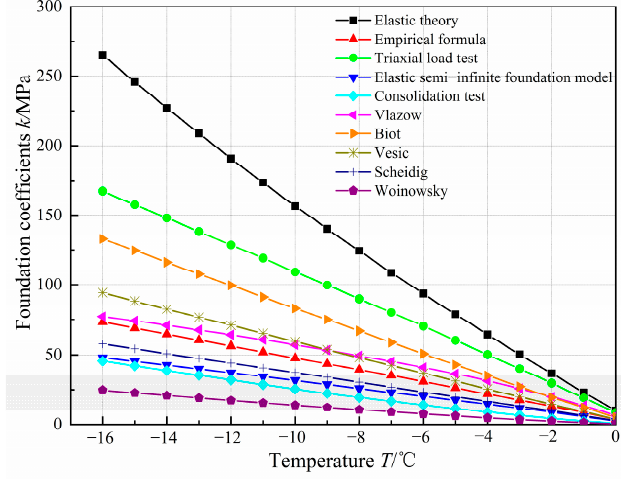
Figure 2. The relationship between foundation coefficient and temperature of different empirical formulas.